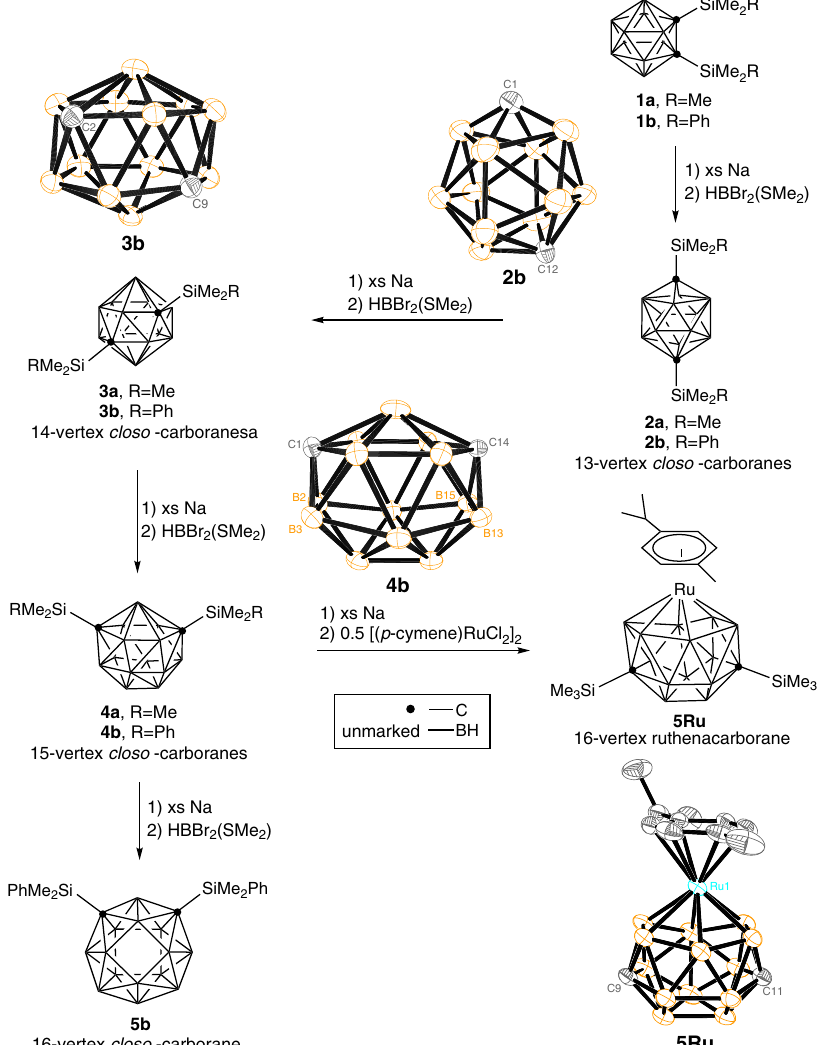
Fig. 1 Synthesis of 13- to 16-vertex closo -carboranes and 16-vertex ruthenacarborane. Synthetic route along with the molecular structures of 13-vertex closo -carborane ( 2b ), 14-vertex closo -carborane ( 3b ), 15-vertex closo -carborane ( 4b ), and 16-vertex ruthenacarborane ( 5Ru ). For clarity, in the X-ray structures, all silyl moieties and hydrogen atoms have been omitted. Orange, B; grey, C.